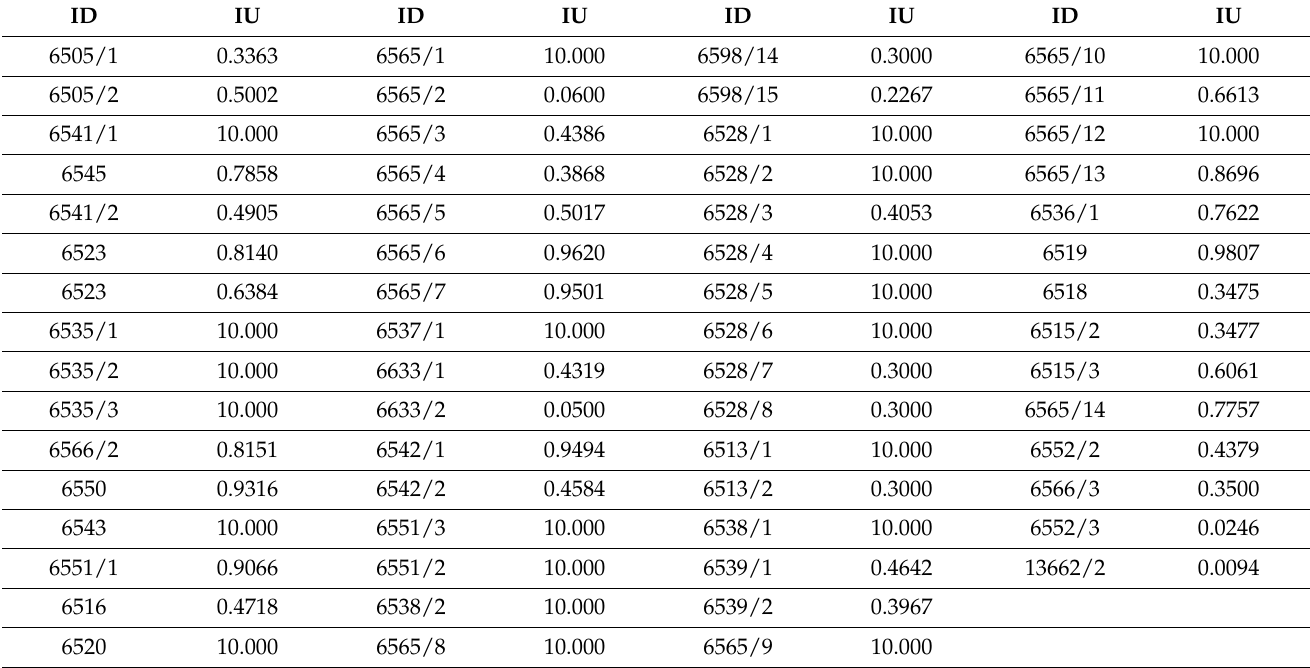
Table 5. Evaluation of the intended utility of cadastral